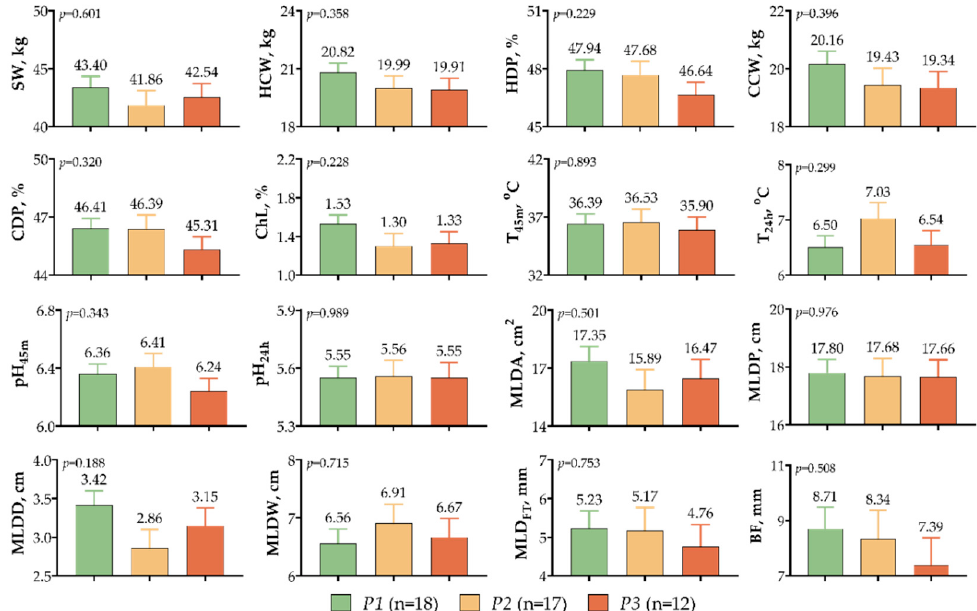
Figure 4. Effect of GHE5 polymorphism on carcass parameters in meat-type lambs. SW: Slaughter weight; HCW: Hot carcass weight; HDP: Hot dressing percentage; CCW: Cold carcass weight; CDP: Cold dressing percentage; ChL: Chilling loss; T 45m : Carcass temperature after 45 min, T 24h : Carcass temperature after 24 h, MLDA: Musculus longissimus dorsi area, MLDP: Musculus longissimus dorsi perimeter, MLDD: Musculus longissimus dorsi depth, MLDW: Musculus longissimus dorsi width, MLD FT : Fat thickness of Musculus longissimus dorsi , BF: Body fatness.